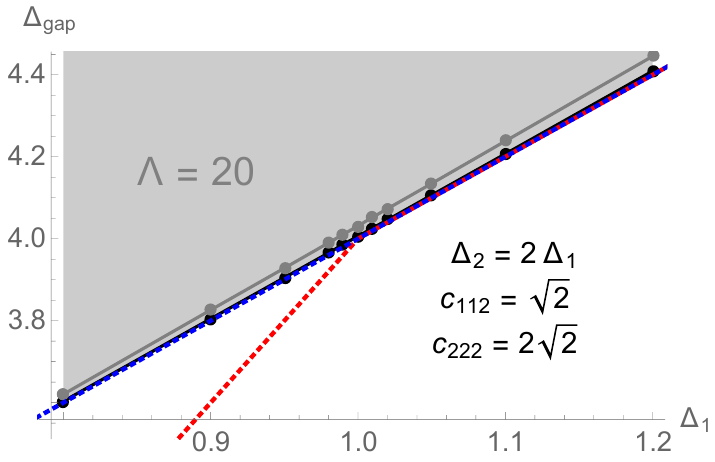
Figure 7 . The maximal value of the gap as a function of ∆ 1 with (∆ 2 , c 112 , c 222 ) as given, which to first order corresponds to switching on only the g 2 deformation. The numerical bounds, obtained with Λ = 10 in gray and Λ = 20 in black, appear to converge to the line 2∆ 1 +2 . The free theory (red dashed line) can only explain this bound for ∆ 1 > 1 . By selectively switching on a φ 8 interaction (blue line) we can also saturate the bound to first order in perturbation theory for ∆ 1 < 1